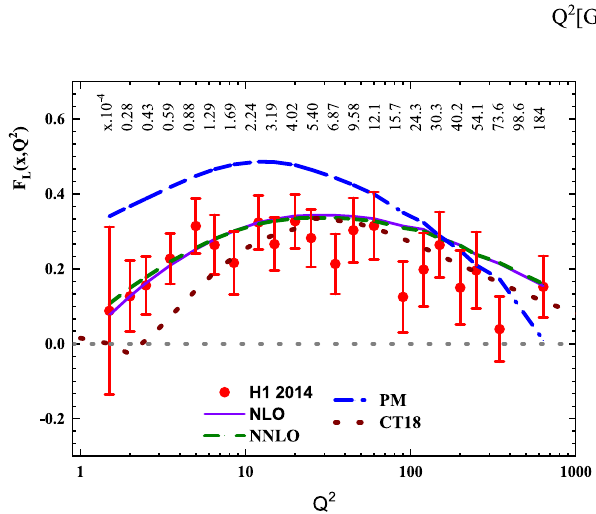
Fig. 5 The nonlinear longitudinal structure function F L at NLO and NNLO approximations averaged over x at different Q 2 . The average value of x for each Q 2 is given above each data point. The nonlinear results at NLO (solid) and NNLO (dashed) compared to the H1 Collab- oration data [67] as accompanied with total errors, the parametrization model [61,62] (dashed-dot) and CT18 [8] (dot) at the NNLO approxi- mation at a fixed value of the invariant mass W = 230